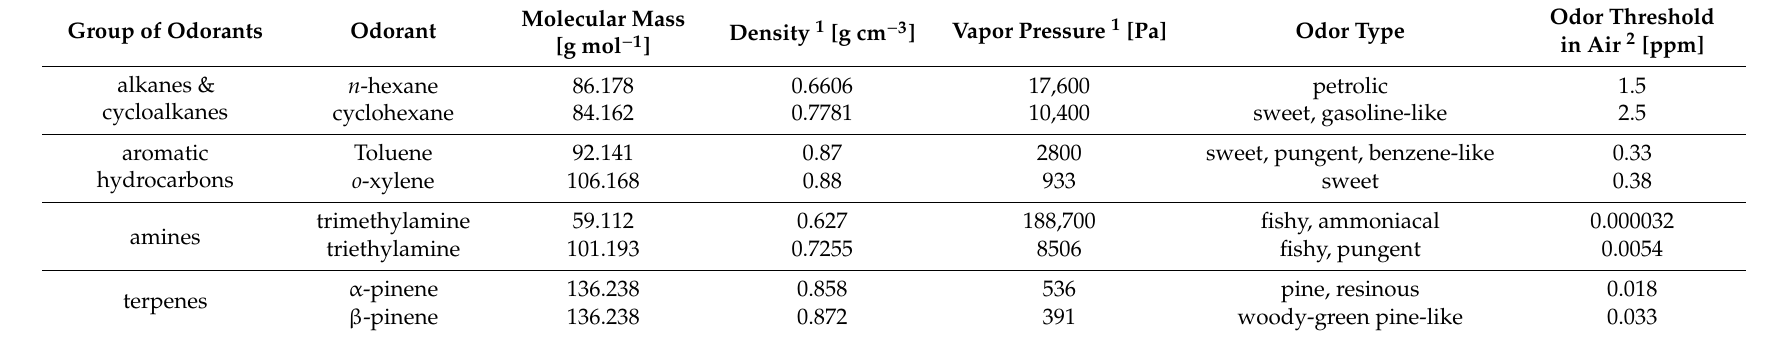
Table 1. Basic properties of odorants sing in the